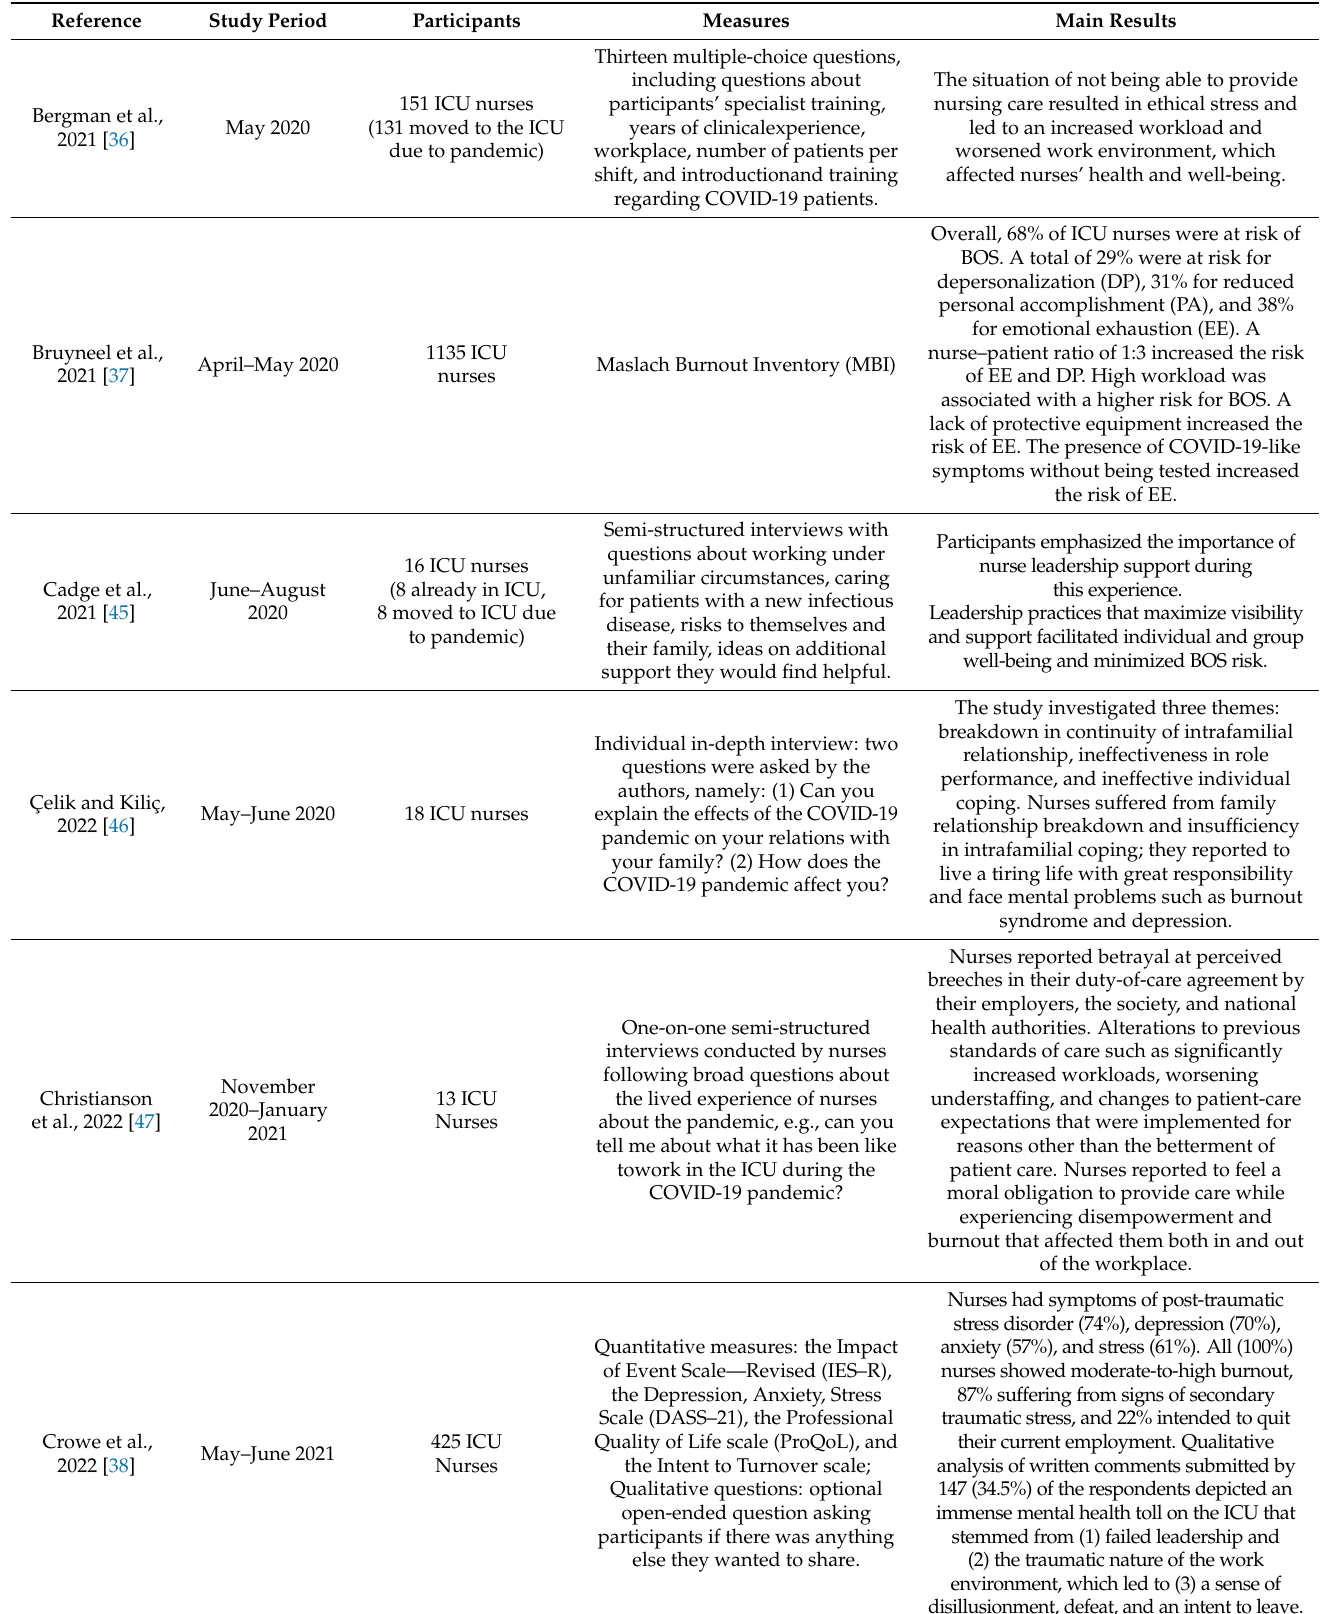
Table 4. Main results of the reviewed